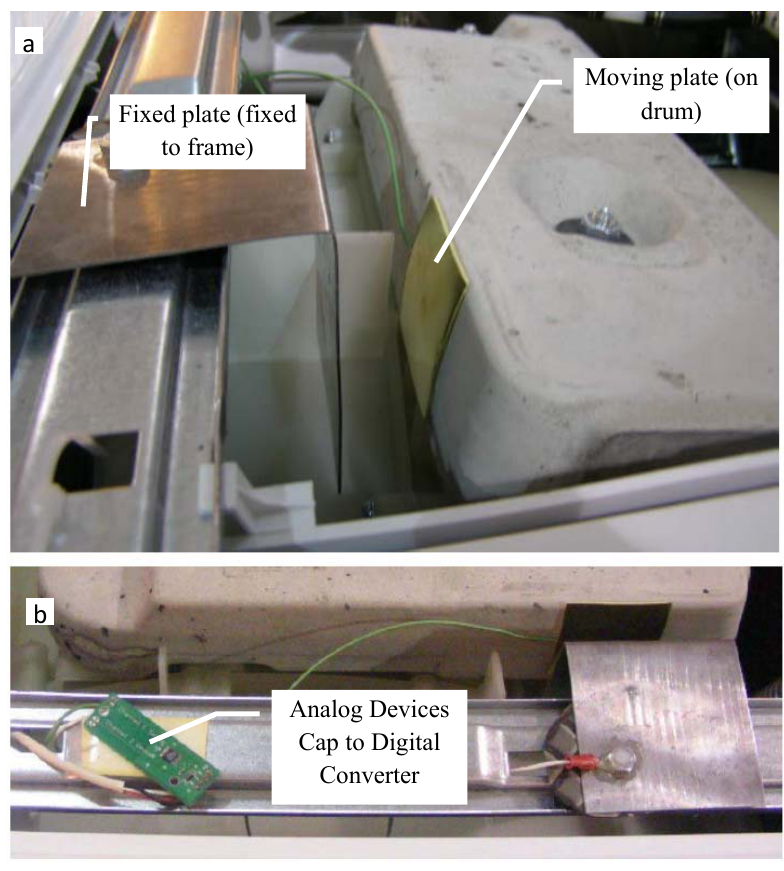
Figure 5. ( a ) Parallel plate configuration setup for displacement measurement on washing machine. ( b ) Capacitance to digital converter (Analog Devices,